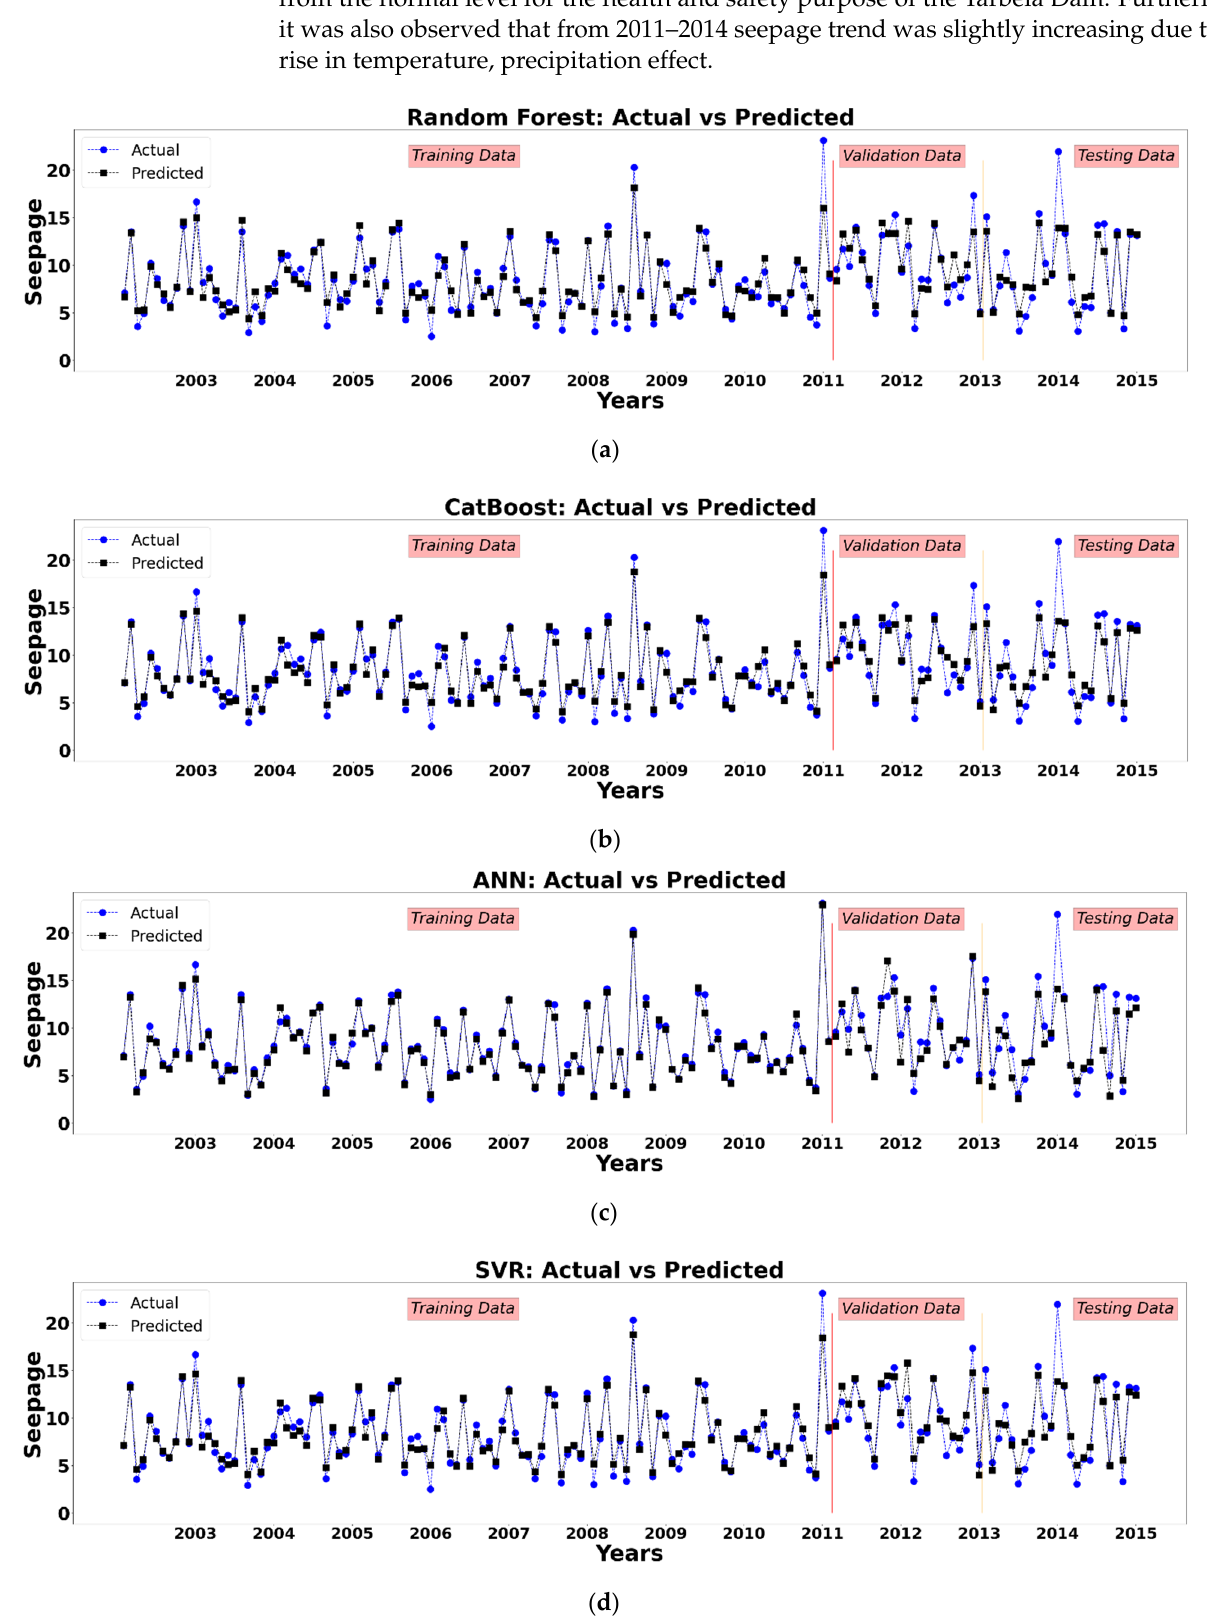
14 of 25 Table 4. Prediction accuracy result of different Machine Learning Models. Model